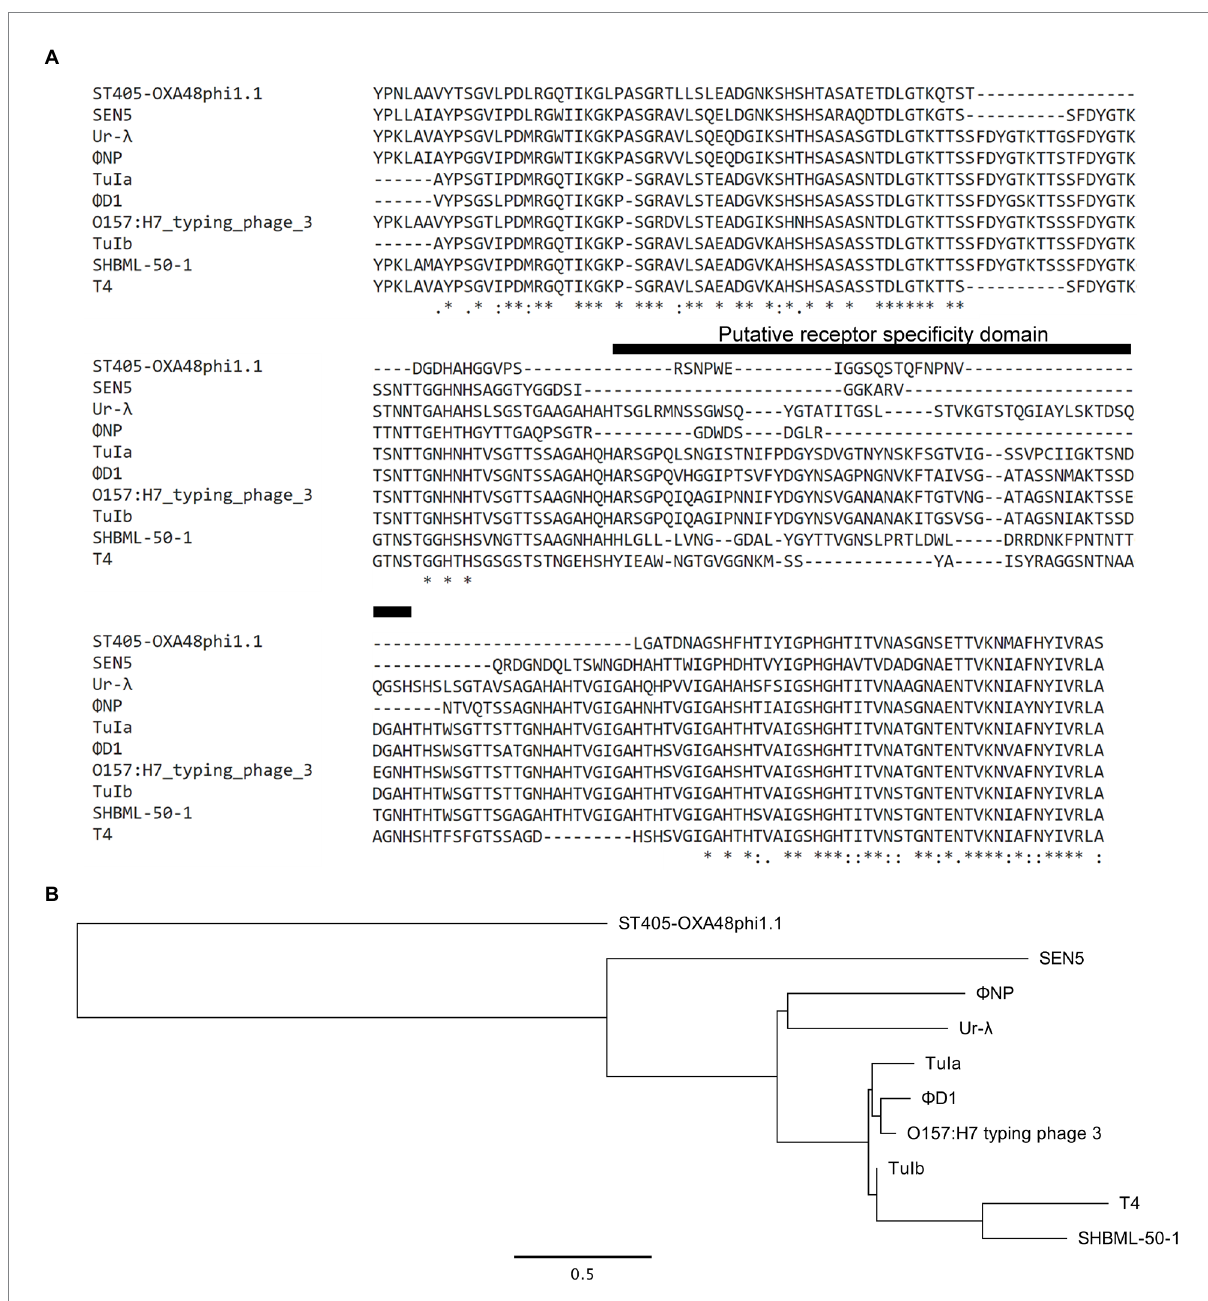
FIGURE 3 Expansion of bioinformatic search reveals the RBP of Φ NP to be a member of a larger novel enteric RBP family based in a T4- and λ -lineage. (A) Amino acid (AA) alignment by ClustalOmega depicting high similarity between Φ NP ORF6 and the distal 215 AAs of the known T4 RBP (gp37), ORF314 of phage λ , and the distal 215 AAs of uncharacterized structural proteins for the Klebsiella pneumoniae phage ST405-OXA-48phi1.1, the E. coli O157:H7 typing phage 3, the Yersinia pestis phage Φ D1, the Salmonella spp. phage SEN5, and the Shigella spp. phage SHBML-50-1. Note the sequence similarity with primary divergence centered around the putative receptor specificity domain of phage T4. (B) Maximum likelihood tree of the putative RBPs of the newly identified enteric RBP family. Trees were constructed using PhyML with default parameters and the General time reversible (GTR) + Gamma model. Branch support was tested using approximate likelihood ratio test (aLRT) based on the Shimodaira-Hasegawa- like (SH-like) procedures and re-tested using 1,000 bootstrap replicates. Tree structures and root positions were verified by Bayesian phylogenetic analysis using BEAST2 under a GTR substitution model, which yielded results consistent with PhyML. Trees are drawn to scale. Scale bars represent the number of substitutions per